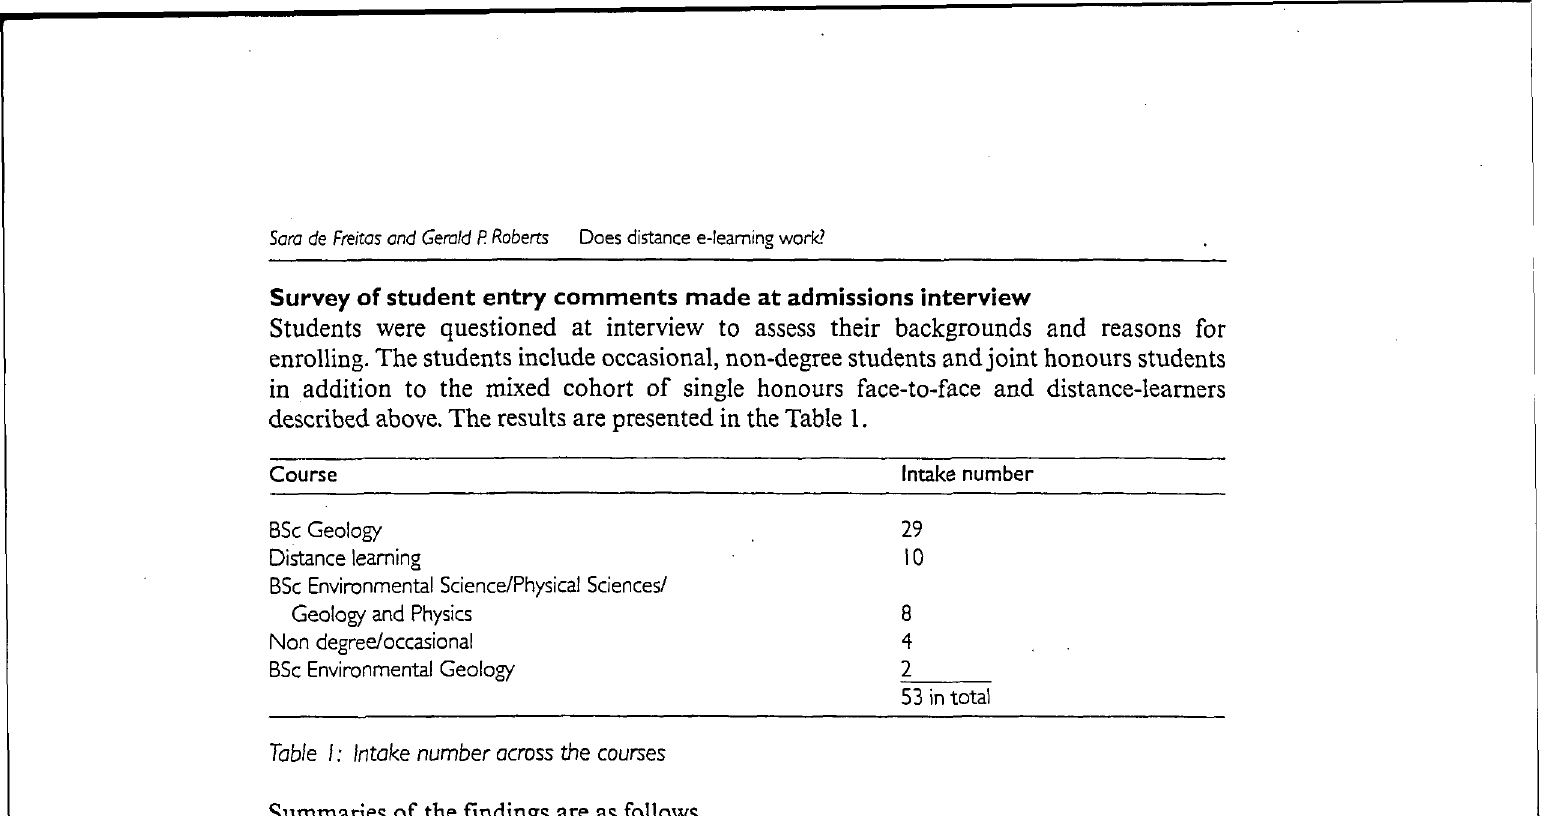
Table I: Intake number across the courses Summaries of the findings are as